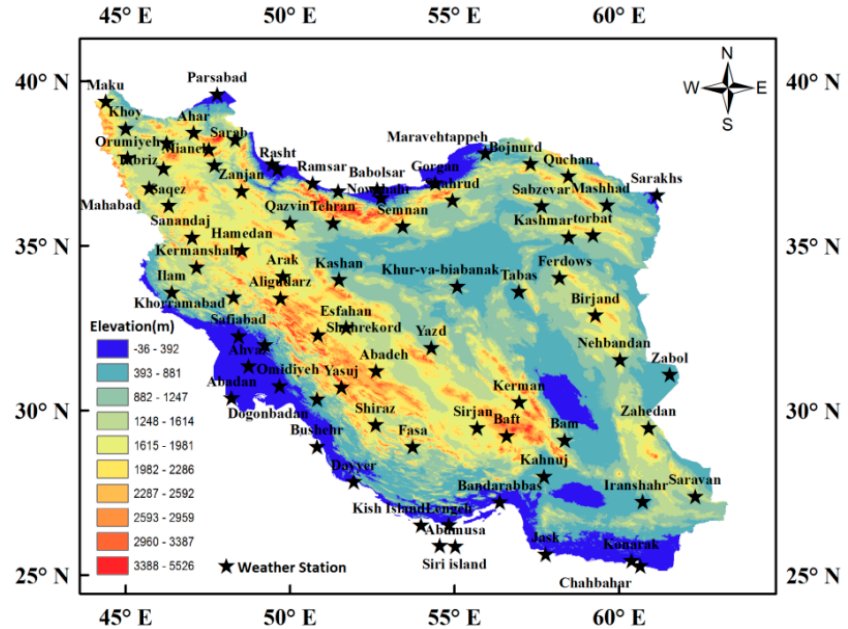
Figure 1. The study area and synoptic weather stations used to model air DTC.